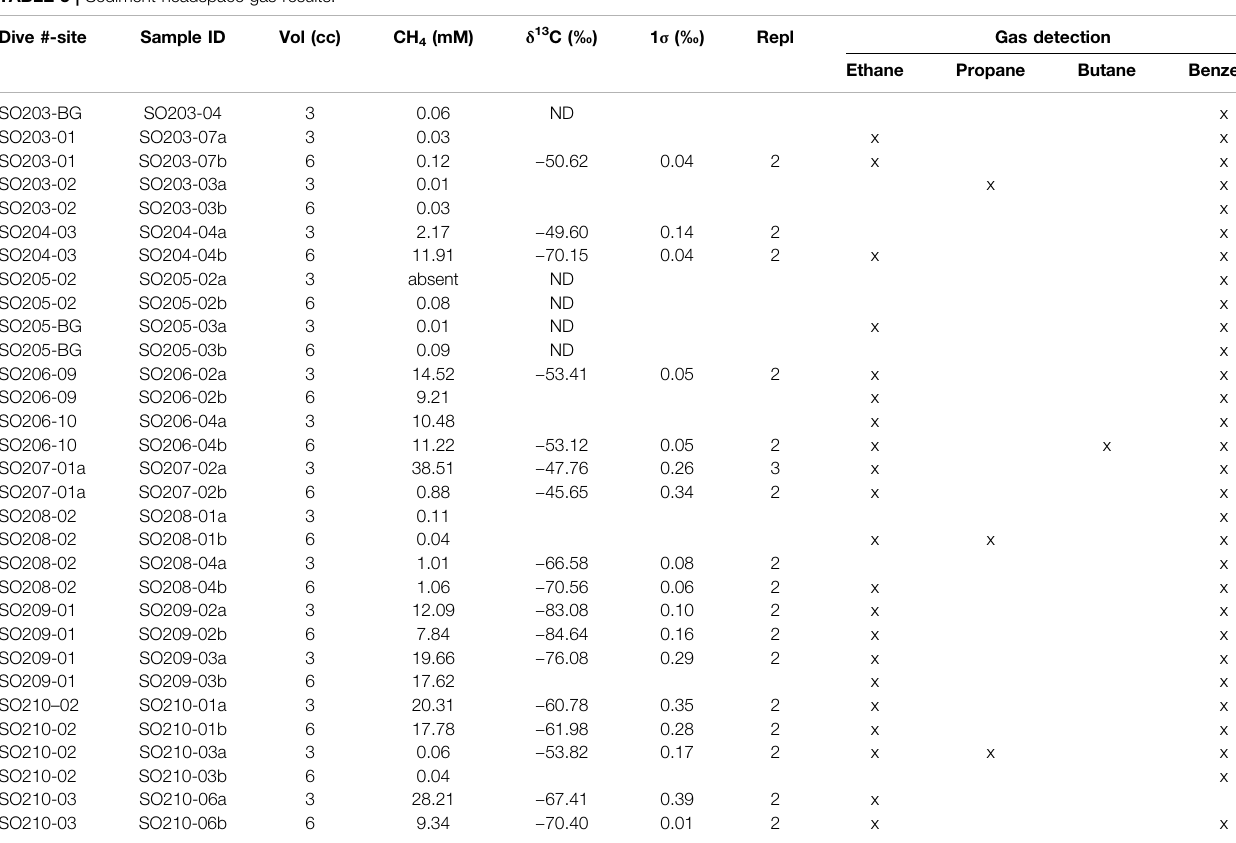
TABLE 3 | Sediment headspace gas